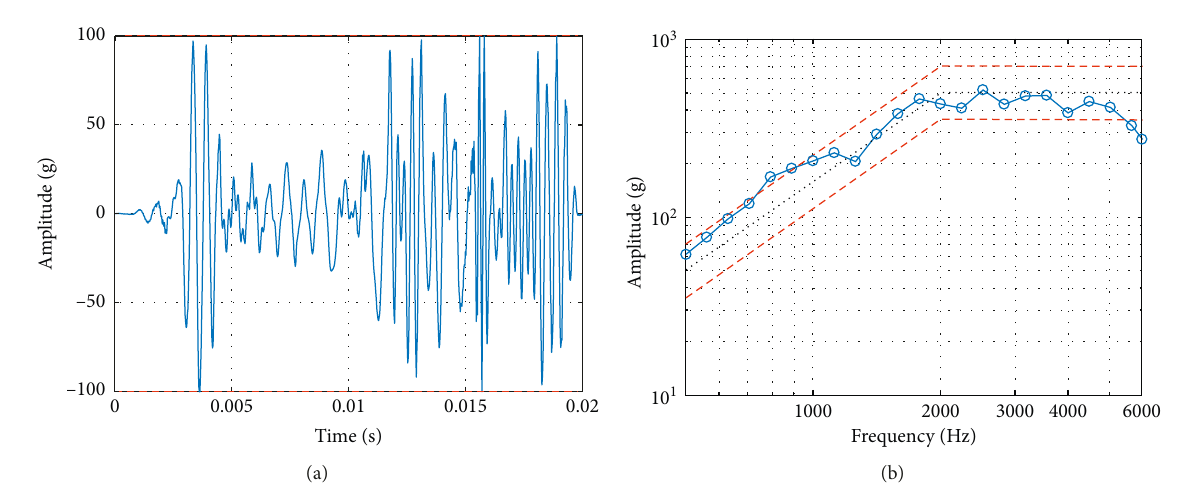
Figure 17: Actual output (a) waveform and (b) its SRS.